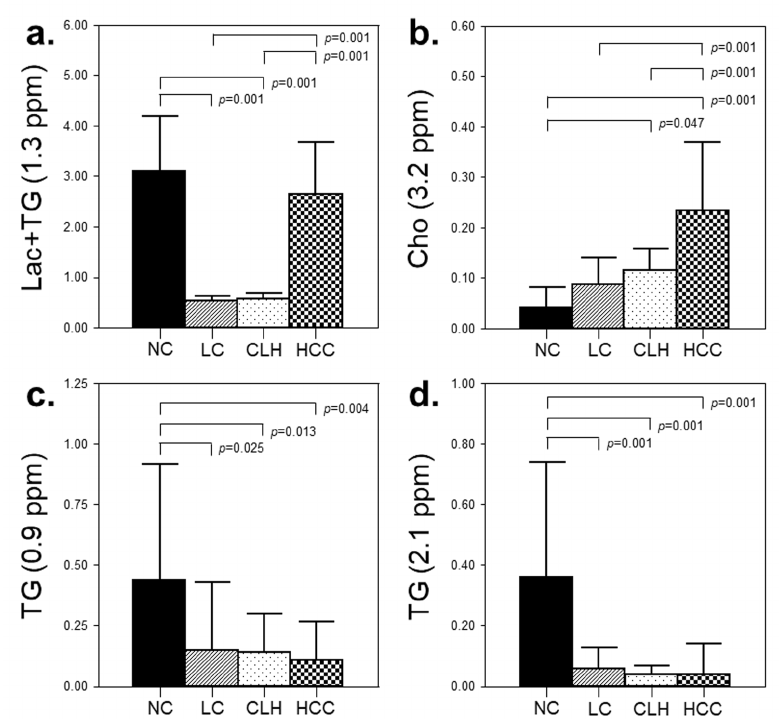
Figure 2. The quantification of the hepatic metabolites for Lac+TG (1.3 ppm) ( a ), Cho (3.2 ppm) ( b ), TG (0.9 ppm) ( c ), and TG (2.1 ppm) ( d ) were evaluated as the relative values to the residual water peak (4.7 ppm). The differential metabolite levels among the four groups were analyzed using analysis of covariance (ANCOVA), with adjustments for age and sex, with Tukey's post-hoc test at p < 0.05. NC, normal control; LC, liver cirrhosis without HCC; CLH, cirrhotic liver with HCC; HCC, hepatocellular carcinoma; Lac+TG, lactate+triglyceride; Cho, choline; TG, triglyceride.